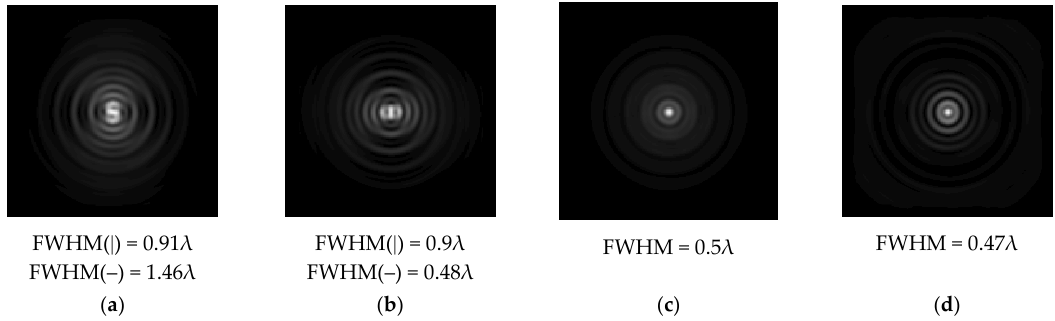
Figure 5. The diffraction of Laguerre–Gauss mode (0,1) by a diffractive axicon with NA = 0.95 in plane of maximum intensity, polarization: ( a ) x-linear, ( b ) y-linear, ( c ) “−” circular, ( d ) radial.